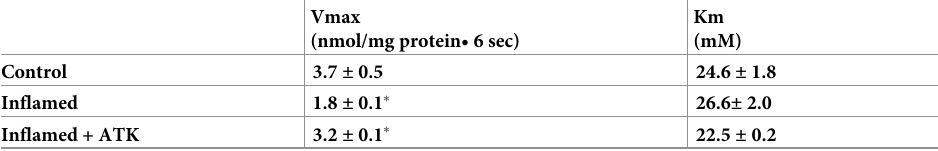
Table 1. Kinetic parameters of Na-glutamine co-transport in AKT treated villus cell